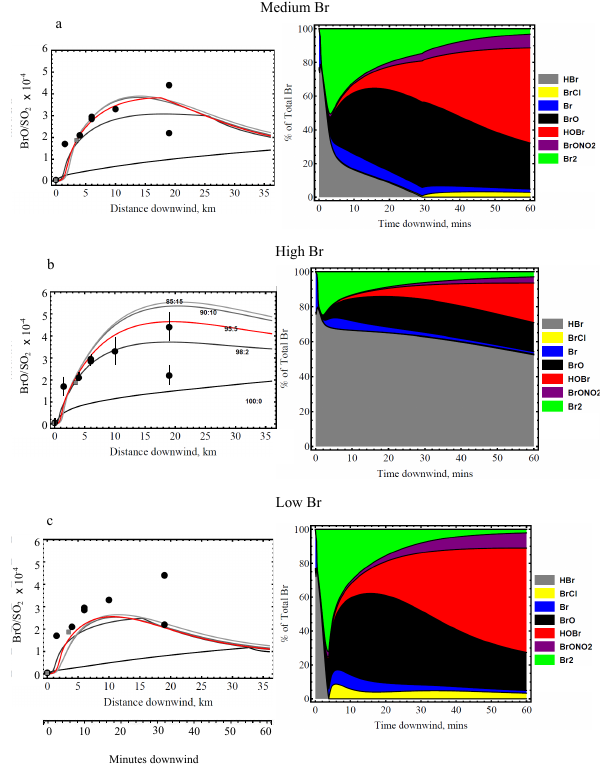
Figure 3. Left: simulated 1h evolution of plume BrO/SO 2 for the three bromine emission scenarios, with varying atmospheric– magmatic gas ratio V A : V M (0:100, 5:95, 10:90, 15:85) in the high-temperature initialisation. Also shown are observed BrO/SO 2 ratios reported by Oppenheimer et al. (2006), and Bobrowski et al. (2007); grey and black disks respectively, with representative data error bars from Bobrowski et al. (2007). Right: Br speciation for the three bromine emission scenarios shown for the model run initialised using HSC with V A : V M =